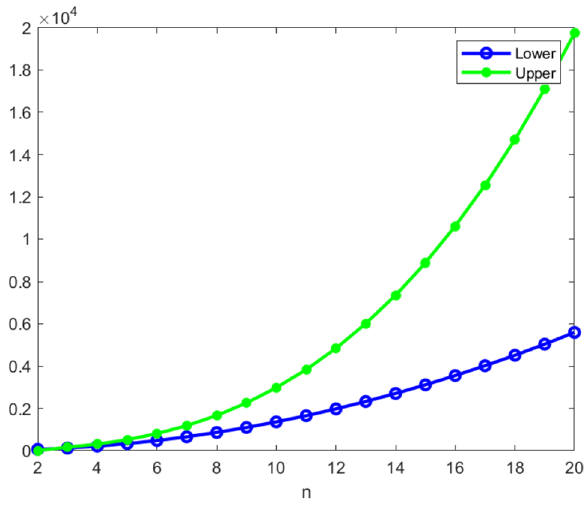
Figure 5. Bounds variations of THC ( n ).